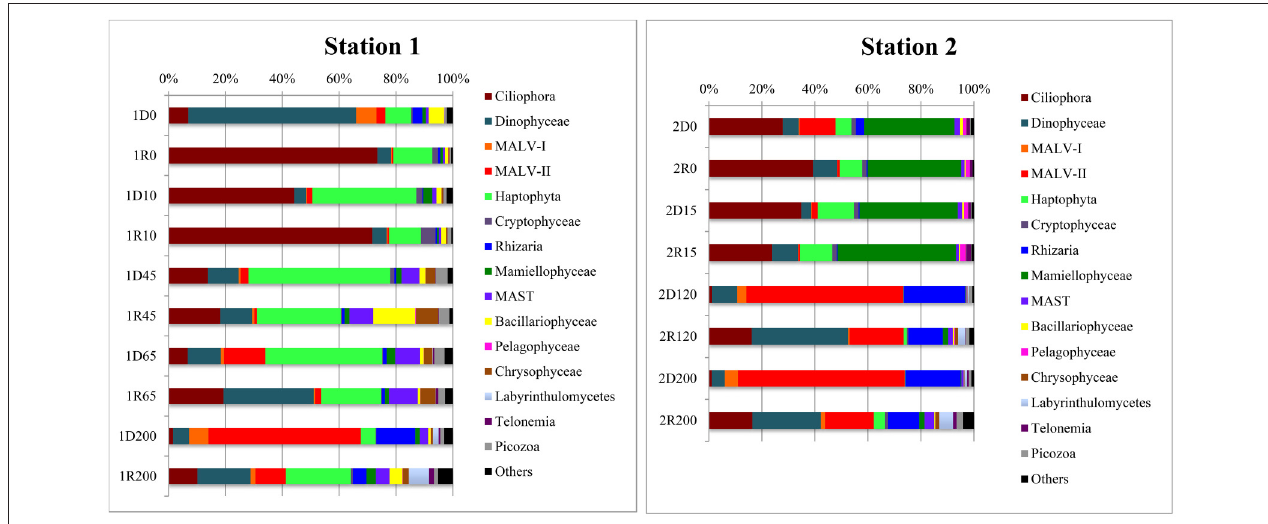
FIGURE 6 | Barchart of eukaryotic OTU (98% sequence similarity) composition in DNA and RNA samples from different depths at Stations 1 and 2. Taxonomy according to Adl et al. (2012). OTUs that did not give clear taxonomic information in BLAST and that had < 1% reads in every sample were lumped together in “Others.” The sample names used in this figure is similar to Figure 5 .